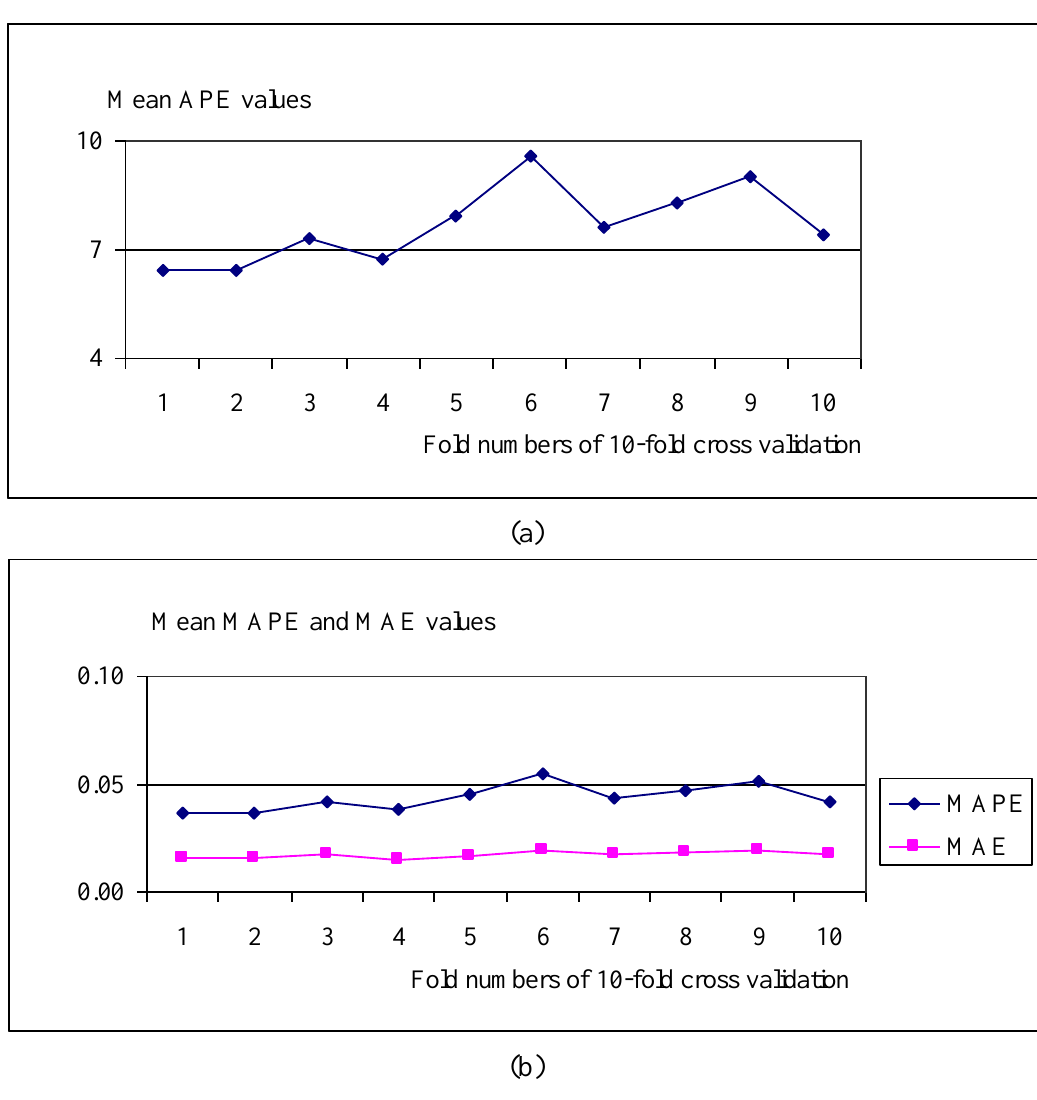
Figure 15 Averages of APEs, MAEs and MAPEs. (a) Averages of APE values of generated faces for each fold; (b) Averages of MAPE and MAE values of generated faces for each fold.